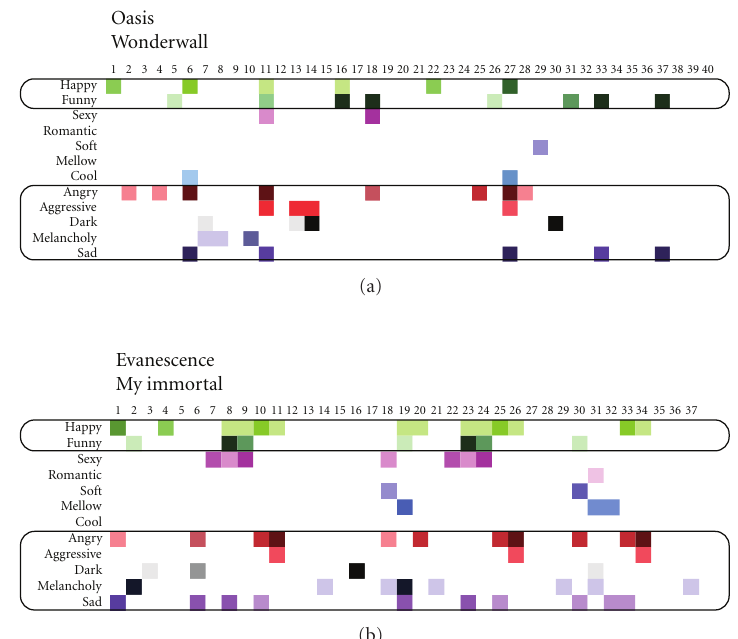
Figure 7: Pairwise comparison of patterns reflecting LSA correlation values in the lyrics of the songs (a) “Wonderwall”, and (b) “My immortal” against 12 a ff ective terms.